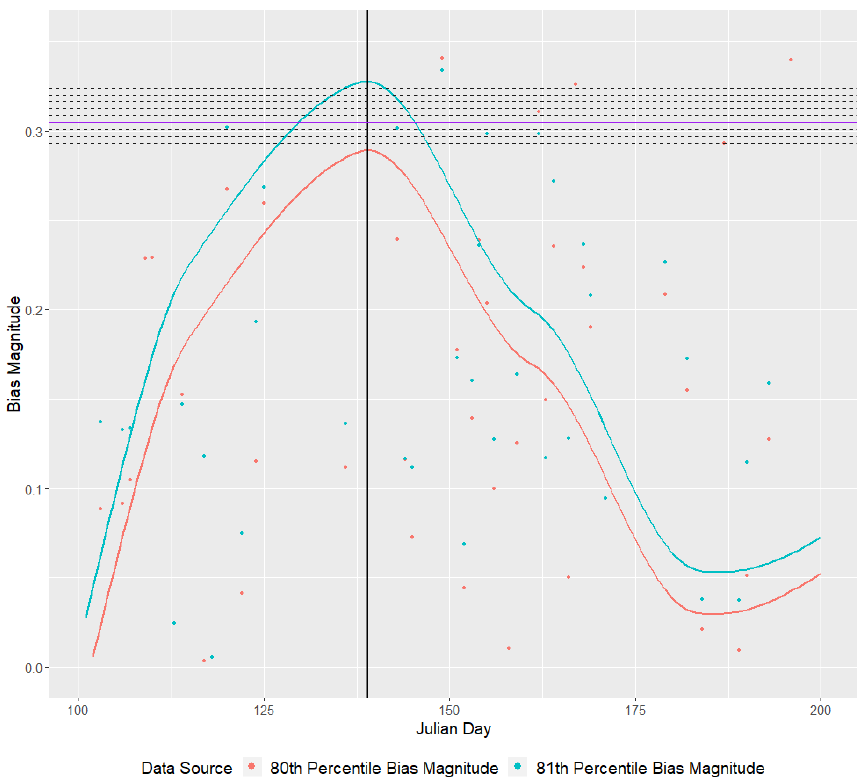
Figure 8. Graphical display of the interpolation process for fitted log precipitation (mm) values, with percentiles falling between p = 0 . 80 and p = 0 . 81 on 19 May (day ν = 139, vertical black line). The red and cyan curves represent the 80th and 81st percentiles of log precipitation as a function of day, respectively. This figure was created using Wickham (2016). Table 3. Maximum daily temperature extrema and deciles ( ◦ C, top panel) and minimum daily temperature extrema and deciles ( ◦ C, bottom panel) for the observed historical (GHCN) climate, the downscaled RCP4.5 climate, and the downscaled